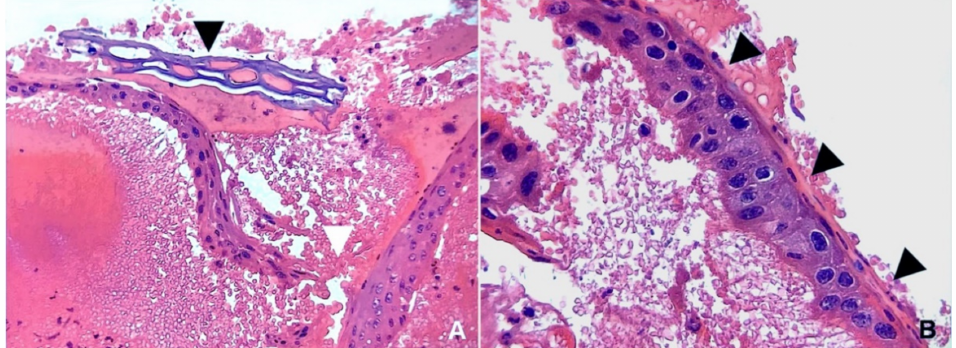
Figure 3. Trachea. ( A ) The lamina propria appears hemorrhagic and a large amount of blood also covers the tracheal epithelium. This appears focally disrupted (white arrowhead) and thickened. In detail, the tracheal epithelium is stratified, with surface cell layers being flattened (squamous metaplasia). Vegetable cells are evident and close to the tracheal mucosa (black arrowhead). Such findings support the incidental inhalation of foreign substances (HE, magnification × 100). ( B ) At a closer view, the squamous metaplasia of the tracheal epithelium (black arrowhead) can be better appreciated (HE, magnification × 200).